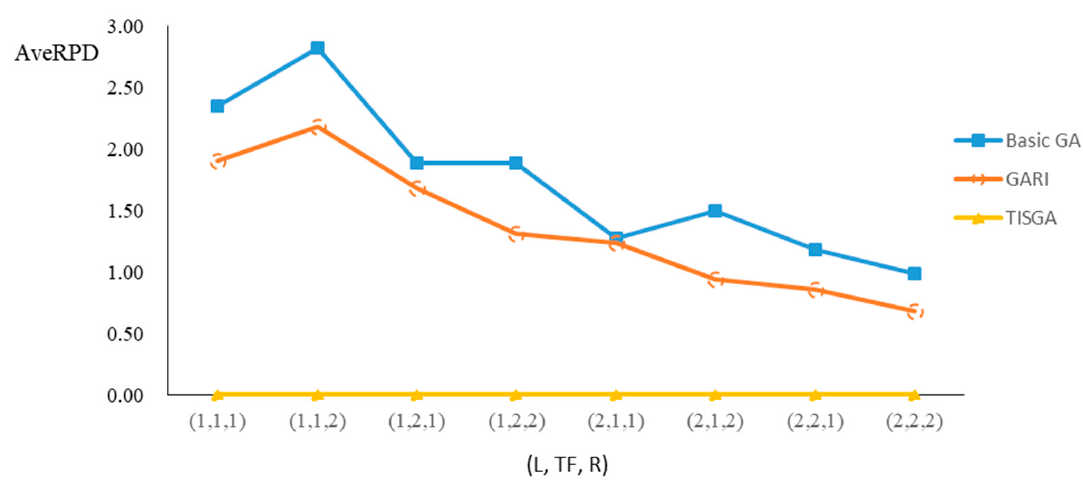
Figure 17. Comparison results for n = 80 with eight combinations of (L, TF, R).